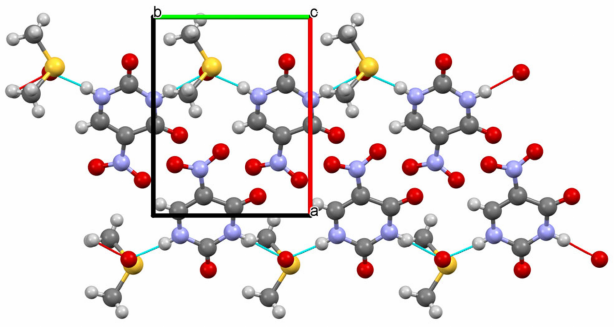
Figure 8. Hydrogen bonded chains in (VII)